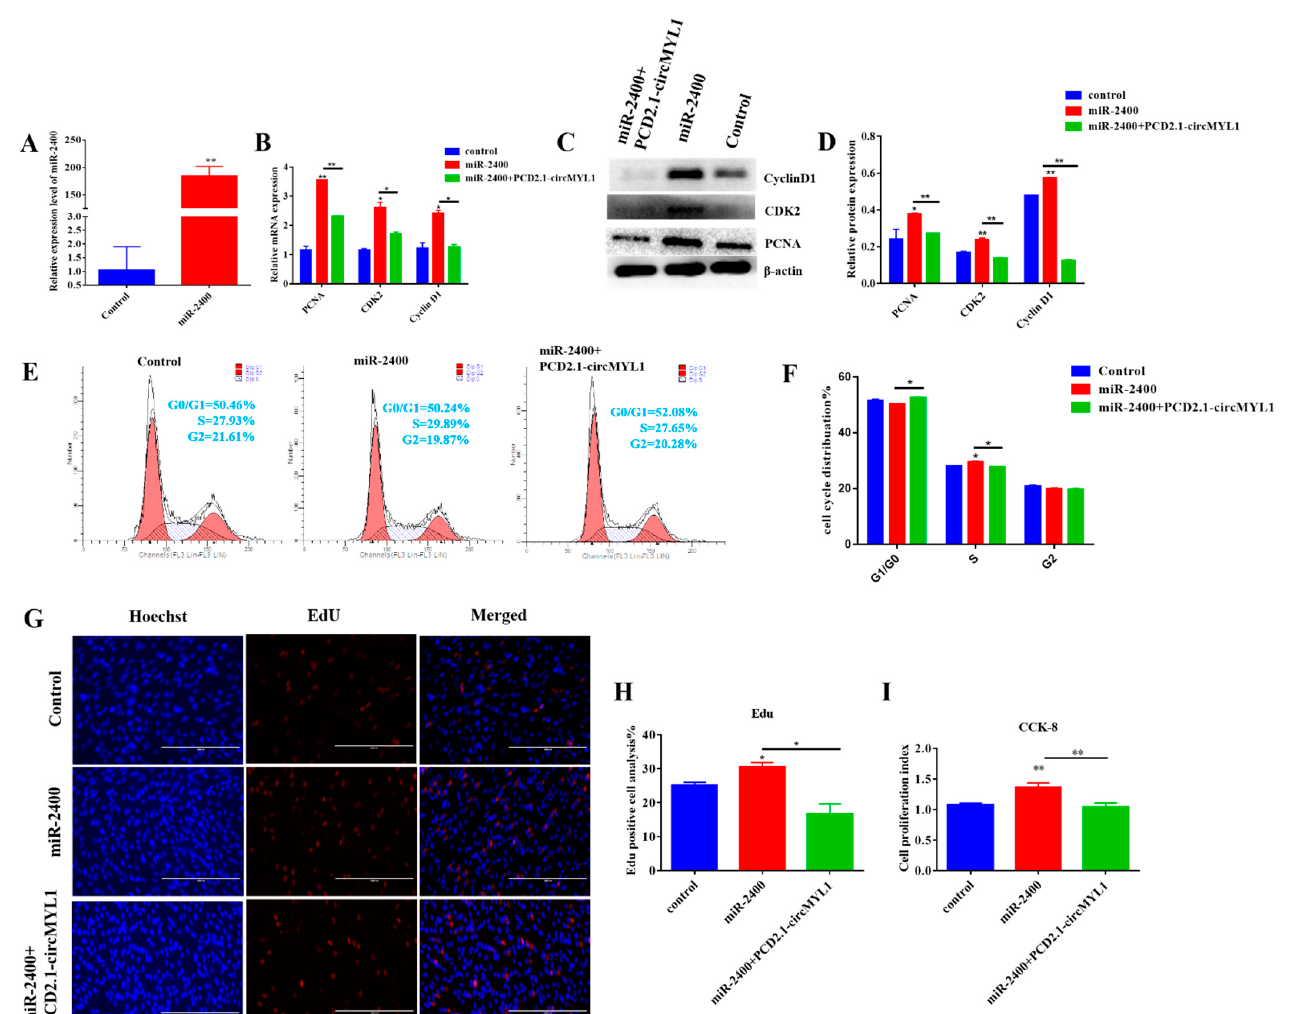
Figure 6. miR-2400 promotes myoblasts proliferation. ( A ) qRT-PCR detected the transfection efficiency of miR-2400 mimic. ( B ) Bovine primary myoblasts were transfected with miR-2400 mimic and/or circMYL1 overexpression vector, and qRT-PCR detected the relative expression levels of proliferation marker genes PCNA , CDK2 , and CyclinD1 . ( C ) Western blot detected the protein expression levels of proliferation marker genes PCNA , CDK2 , and CyclinD1 . ( D ) Histogram graph showing the protein band density evaluated using ImageJ. ( E ) The cell cycle was analyzed by flow cytometry. ( F ) Histogram graph showing the number of cells in each phase of the cell cycle. ( G ) The cell proliferation was detected by (EdU) assay Scale bar, 200 μ m. ( H ) Graph of a histogram showing the percentage of EdU-positive cells. ( I ) The cell counting kit- 8 (CCK-8) assay was used to detect the cell proliferation index. Data are shown as mean ± SEM. n = 3. * p < 0.05; ** p < 0.01.